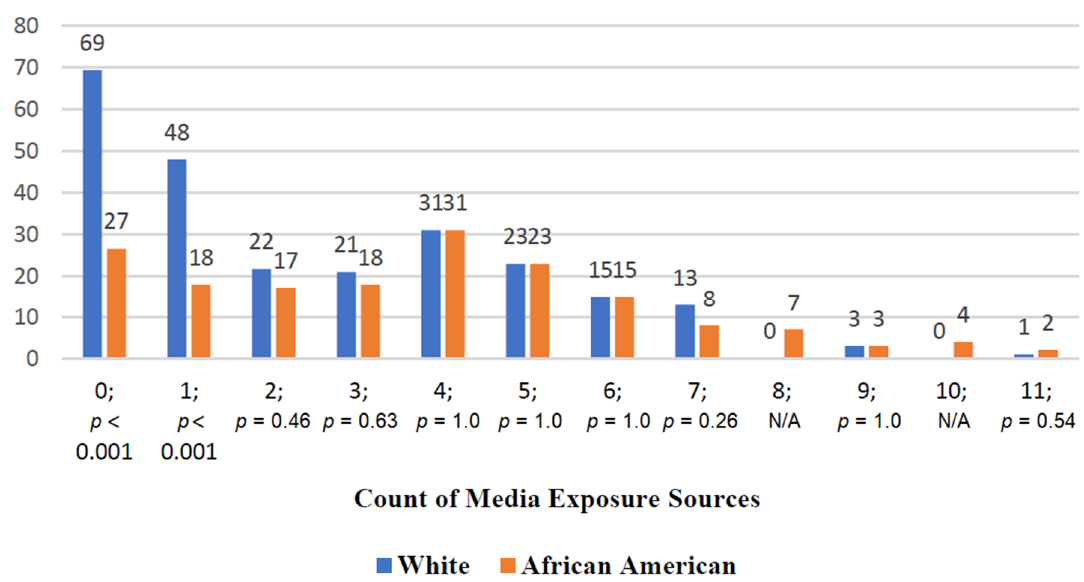
Figure 2. Count of media exposure sources by race. The numbers “0–11” refer to the number of sources through which media exposure to breastfeeding promotional messages was received. The majority of the variability is found in the “0” and the “1” media source categories ( p < 0.001). These results are the basis for the negative binomial regression model.